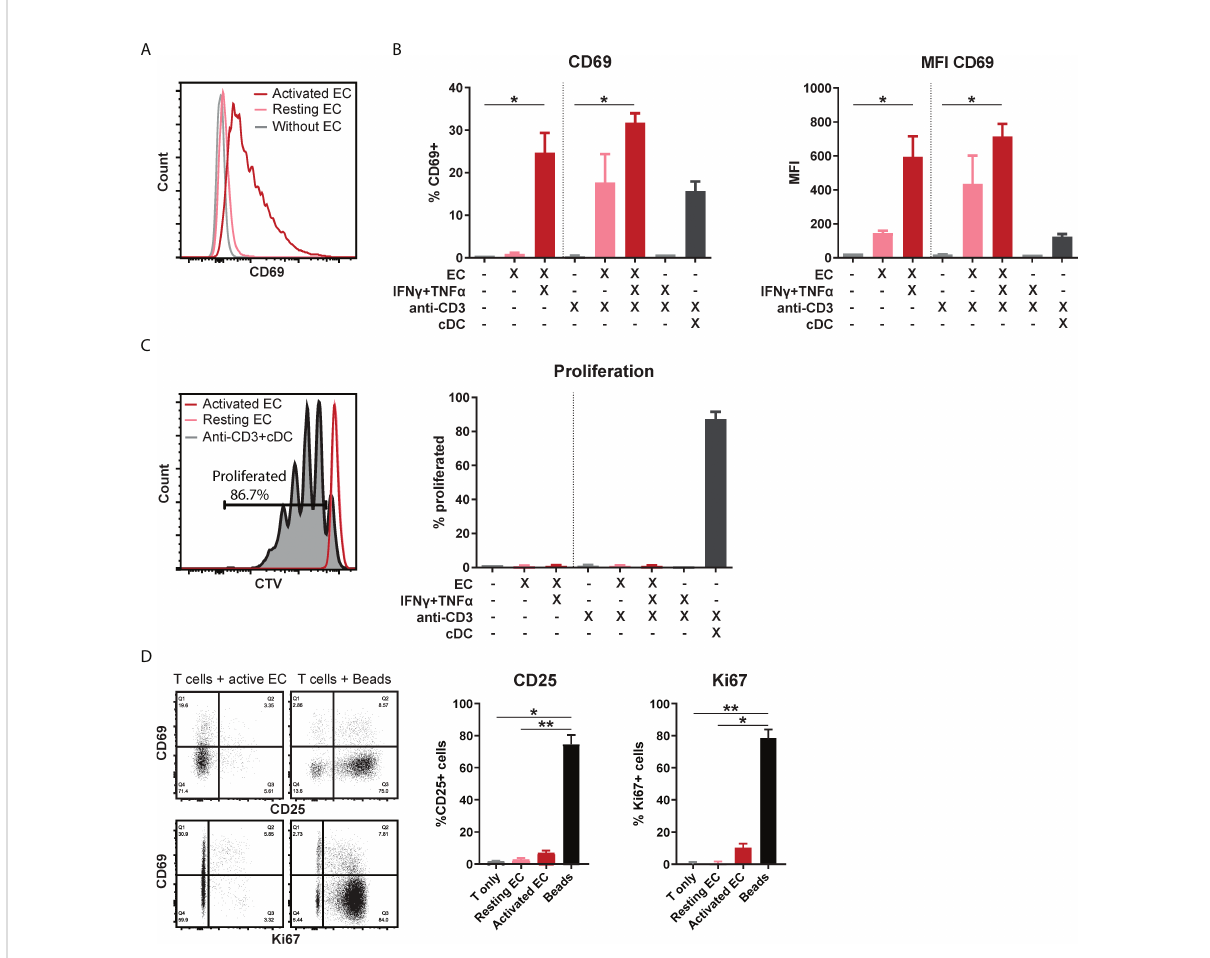
FIGURE 1 Activated EC induce CD69 expression in T cells, without proliferation or activation. HMEC were left unstimulated or stimulated with TNF a and IFN g for 3 days before addition of FACS-sorted CD3+ T cells to the co-culture, in the presence or absence of soluble anti-CD3 stimulation. Conventional dendritic cells (cDC) were added as a positive control to induce T cell proliferation. CD69 expression was analyzed by fl ow cytometry after 4 days of co-culture. (A) Representative fl ow cytometry plot, (B) percentage of positive cells and median fl uorescent intensity (MFI). Kruskal-Wallis with Dunn ’ s post-hoc test compared to unstimulated, c.q. only anti-CD3 stimulated T cells. *p < 0.05. (C) Proliferation was assessed by CellTrace Violet (CTV) dilution assay. Kruskal-Wallis with Dunn ’ s post-hoc test. (D) Expression of CD25 and Ki67 after 4 days of co- culture with unstimulated T cells, resting/activated HMEC or anti-CD3/CD28 beads. N = 3, mean+SEM. Kruskal-Wallis with Dunn ’ s post-hoc test. *p < 0.05, **p <